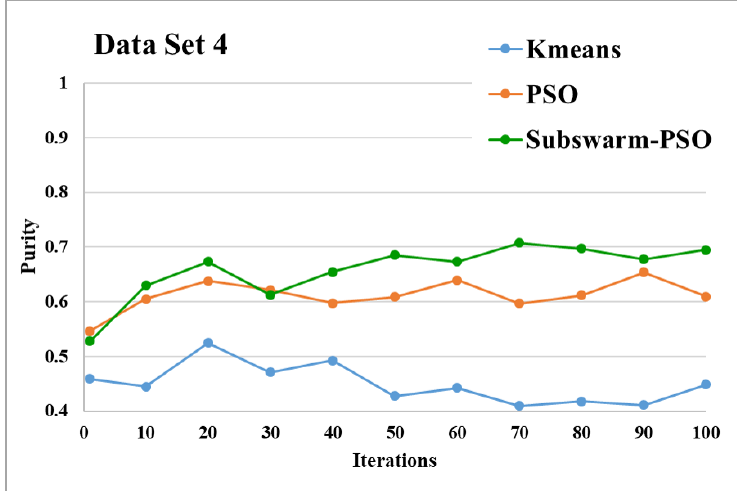
Figure 11. Purity comparison for data set 4.